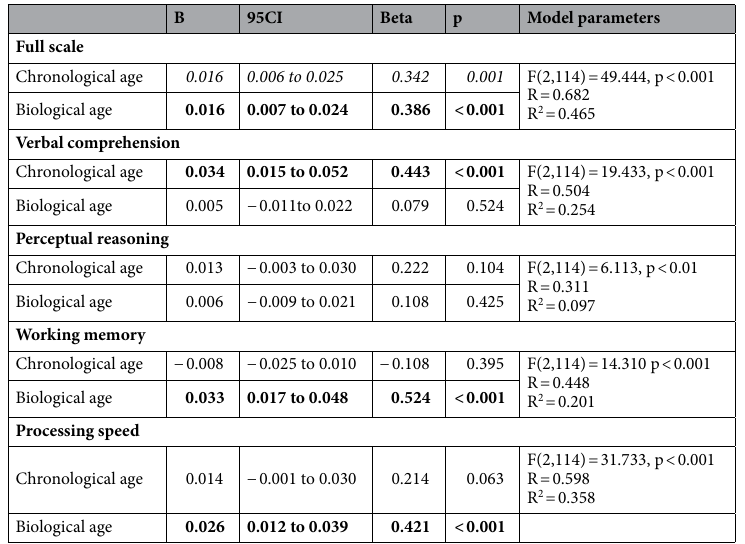
Table 2. Multiple linear regressions for the effects of chronological/biological age on WISC-IV overall performance and on the four factors. Italicised values: p < 0.01, Bold values: p < 0.001. Multiple linear regressions for chronological age/biological age on WISC-IV broad abilities and overall performance. B unstandardised coefficients, beta standardised coefficients, 95CI 95% confidence